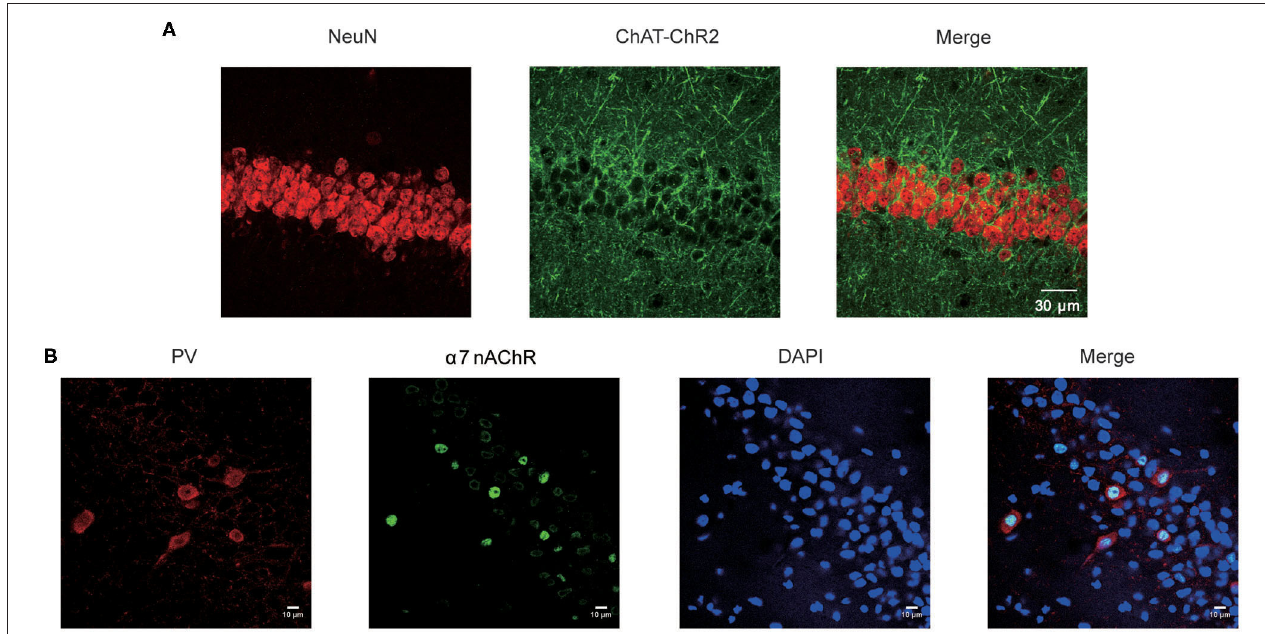
FIGURE 1 | Expression of α 7 nAChR in the CA1 neurons in hippocampus. (A) Fluorescence images showing CA1 sections stained for the NeuN and the cholinergic neuron projections in the Chat-ChR2-EYFP mice. (B) Immunostaining of the hippocampal pyramidal layer with neurons and α 7 nAChRs, showing the expression pattern of α 7 nAChRs on PV GABAergic neurons and non-PV